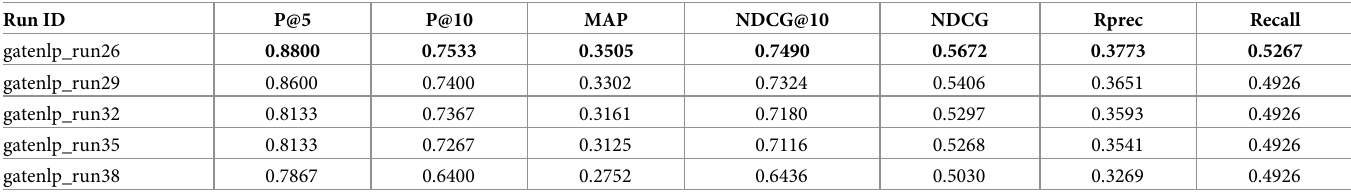
Table 5. Results for monolingual French runs. All runs retrieve 200 documents per query as there were no runs submitted by any team which retrieve 1000 documents per query. Best overall scores are highlighted in